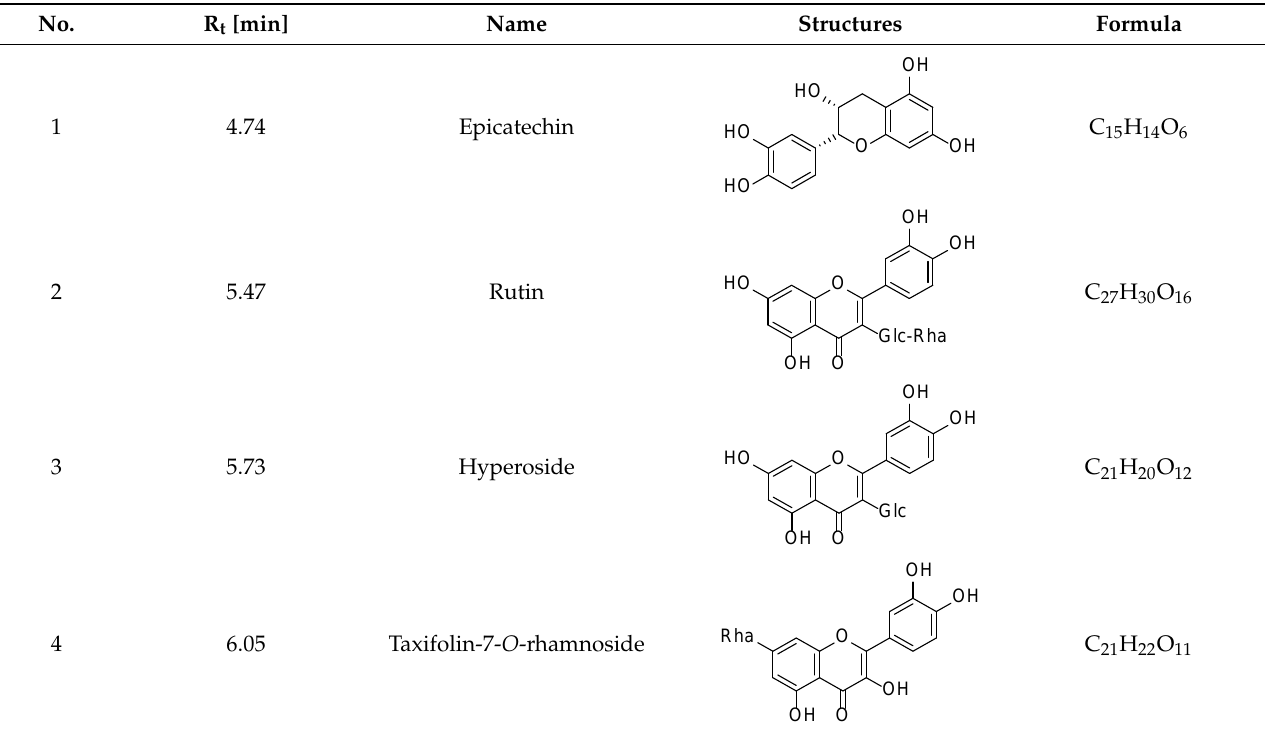
Figure 2. Ten selected active compounds in H. kouytchense insect gall extracts analyzed by UPLC–MS (negative mode). Table 2. Properties of the 10 selected active compounds in the H. kouytchense insect gall extracts.